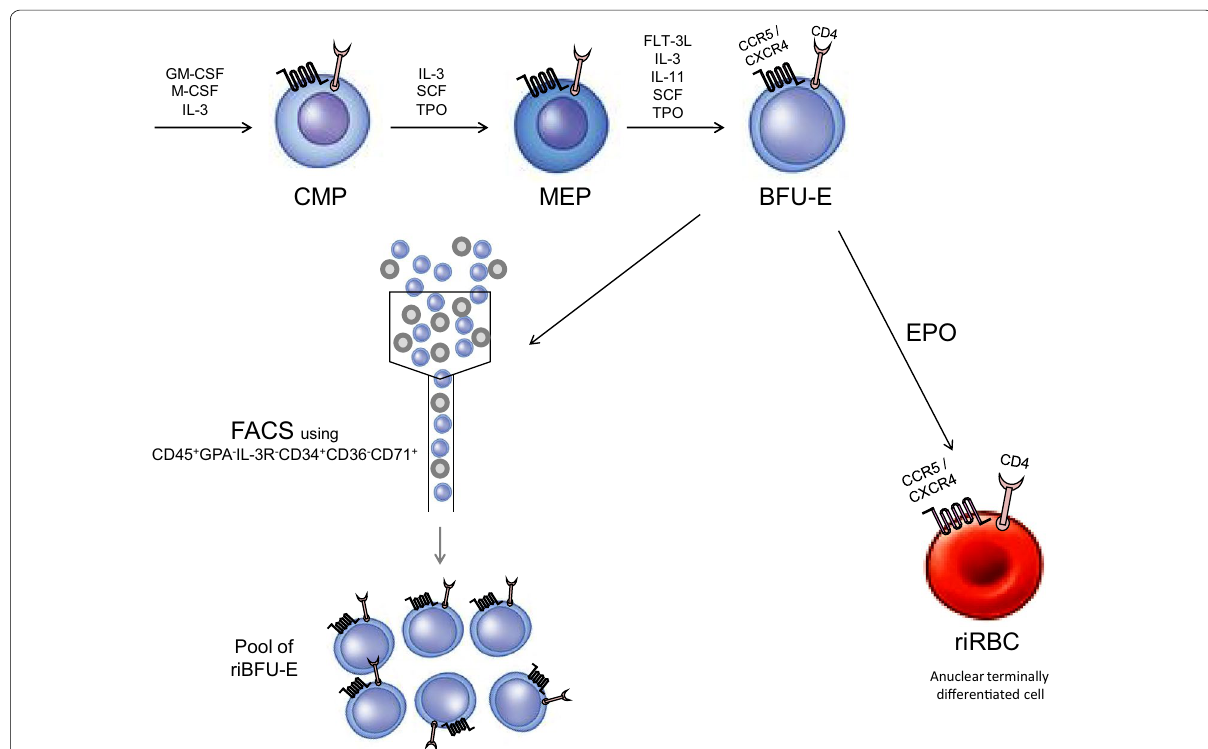
Fig. 2 In vitro formation of riBFU-E and mature riRBC from riHSC. The formed riHSC from the stem cells will then be treated with several in vitro growth and differentiation factors like GM-CSF, M-CSF, IL-3, SCF, TPO etc. to obtain BFU-E having HIV receptor-co-receptor complex. Then, these riBFU-E cells will be selected and isolated from other cell lineages by FACS using CD45 + GPA − IL-3R − CD34 + CD36 − CD71 + markers to finally yield pool of pure riBFU-E cells. Another large population of cells having mixed population of riBFU-E and other lineages like lymphoid and myeloid cells will be treated by EPO to finally obtain only mature riRBC. GM-CSF granulocytemacrophage colony stimulating factor, M-CSF macrophage colony- stimulating factor, IL-3 interleukin-3, IL-11 interleukin-11, SCF stem cell factor, TPO thrombopoietin, FLT-3L Fms-related tyrosine kinase 3 ligand, CMP common myeloid progenitor, MEP megakaryocyte/erythrocyte progenitor, BFU-E burst forming unit-erythroid, riRBC receptor integrated red blood corpuscle, FACS fluorescence-activated cell sorting, riBFU-E receptor integrated burst forming unit-erythroid, EPO